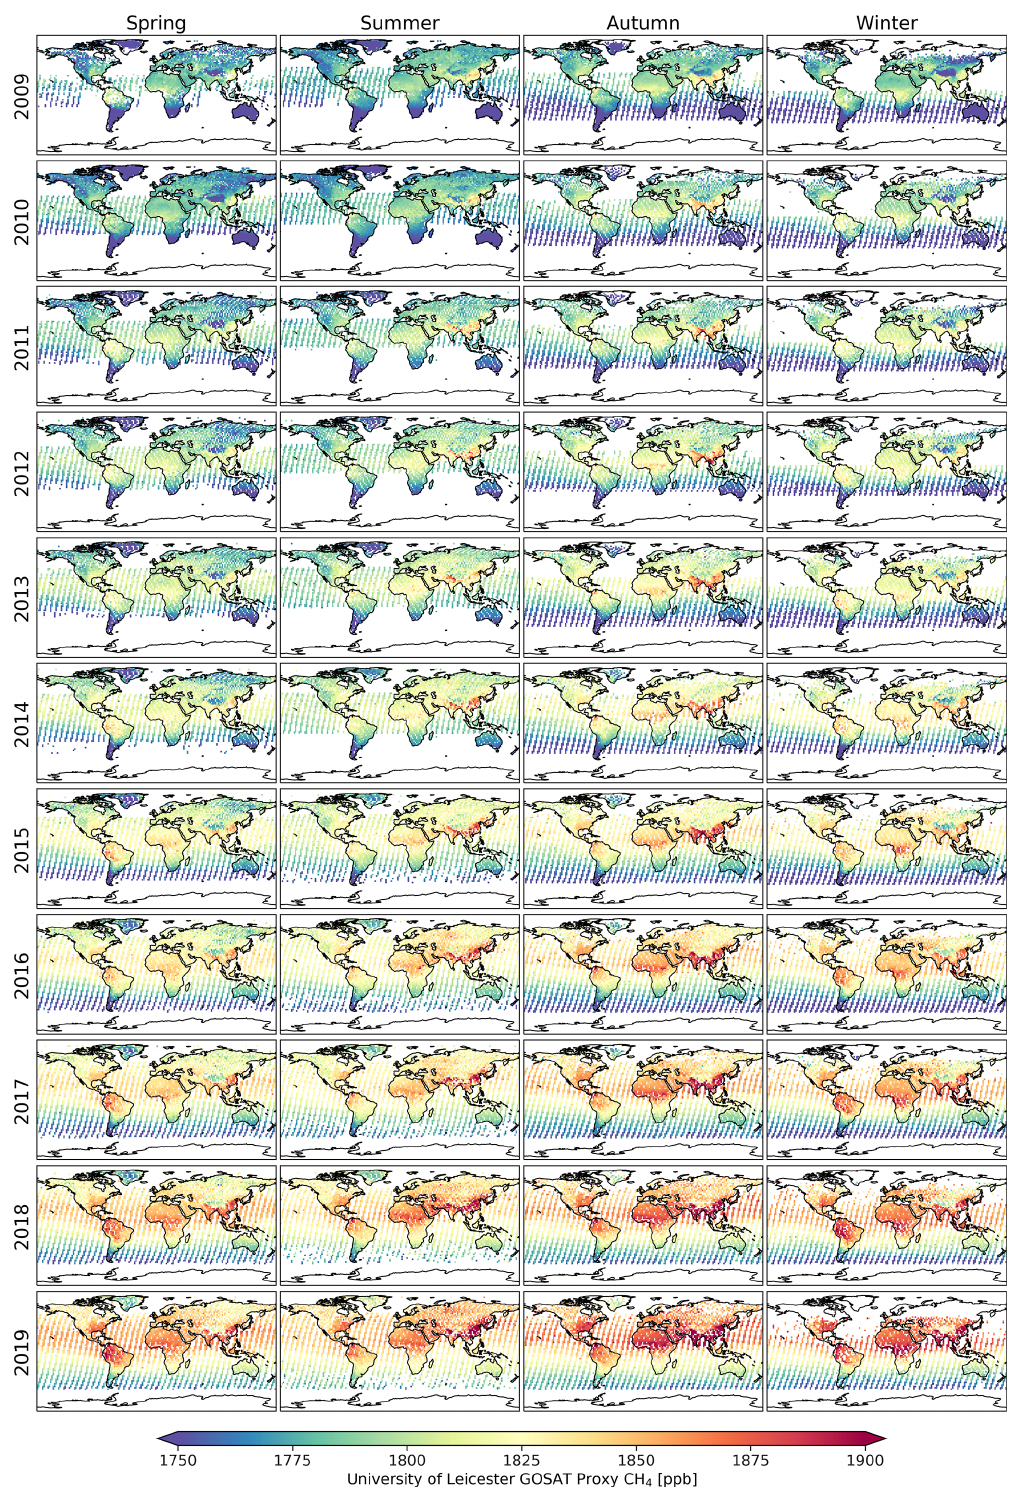
Figure 10. Global maps showing the GOSAT Proxy XCH 4 data from April 2009 to December 2019 separated into seasons – spring (MAM), summer (JJA), autumn (SON) and winter